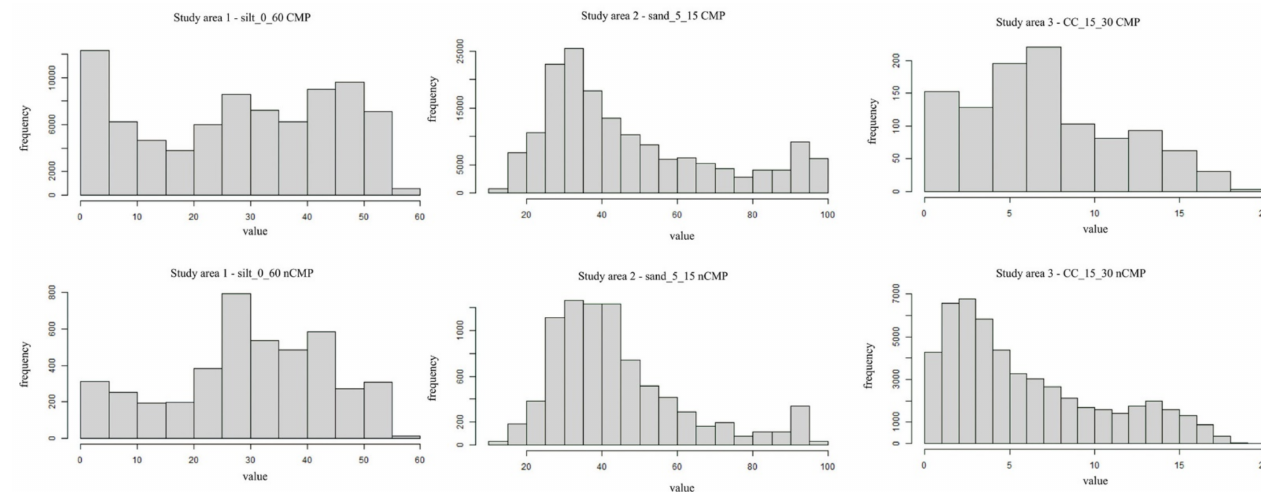
Figure 5. The histograms of the raster cell values for the two data sets (CMPs and nCMPS) in the case of the most discriminating soil properties for the three study